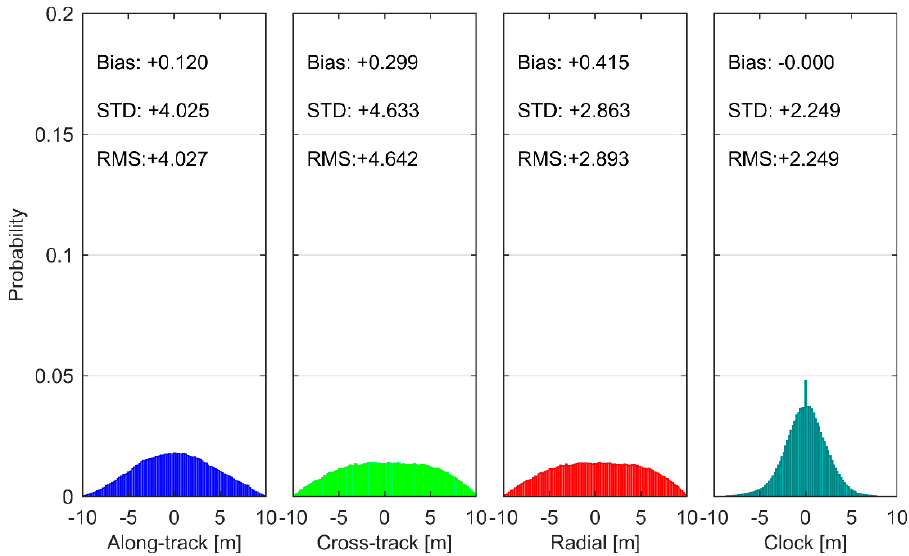
Figure 6. The distribution of SBAS-derived orbit and clock errors for MSAS PRN 129.